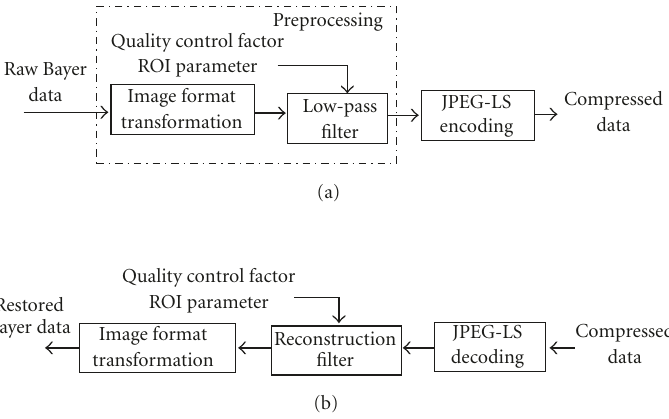
Figure 3: Block diagrams: (a) the proposed near-lossless compression algorithm and (b) the corresponding decompression algorithm.